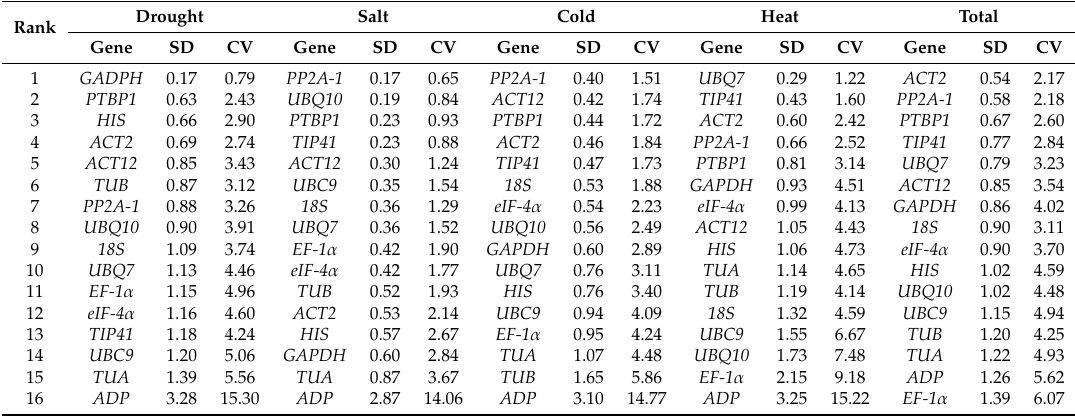
Table 5. Gene expression stability in L. olgensis . under multiple stress treatments, as ranked by the software program BestKeepers.